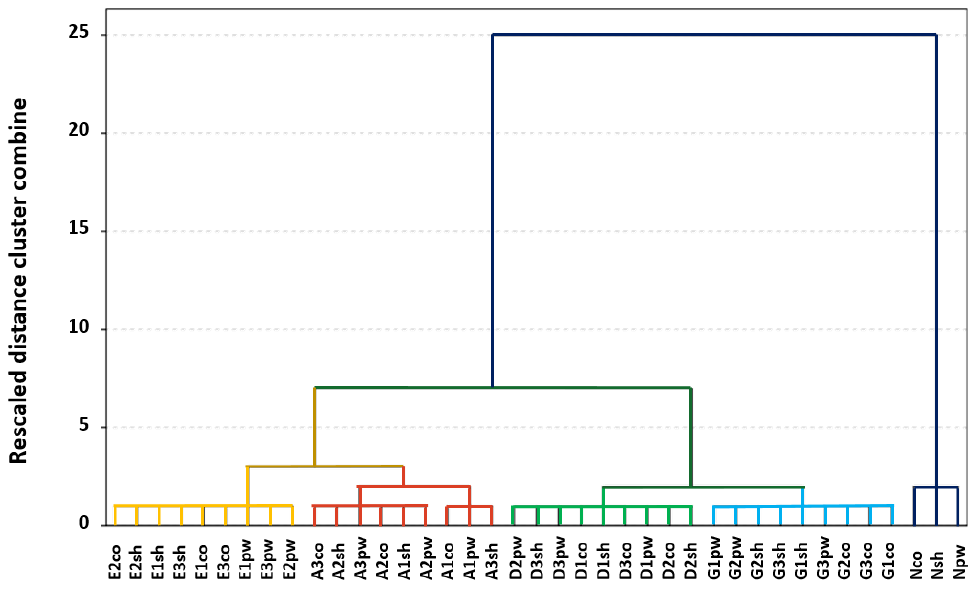
Figure 2. Dendrogram obtained from the hierarchical cluster analysis using the Ward method.